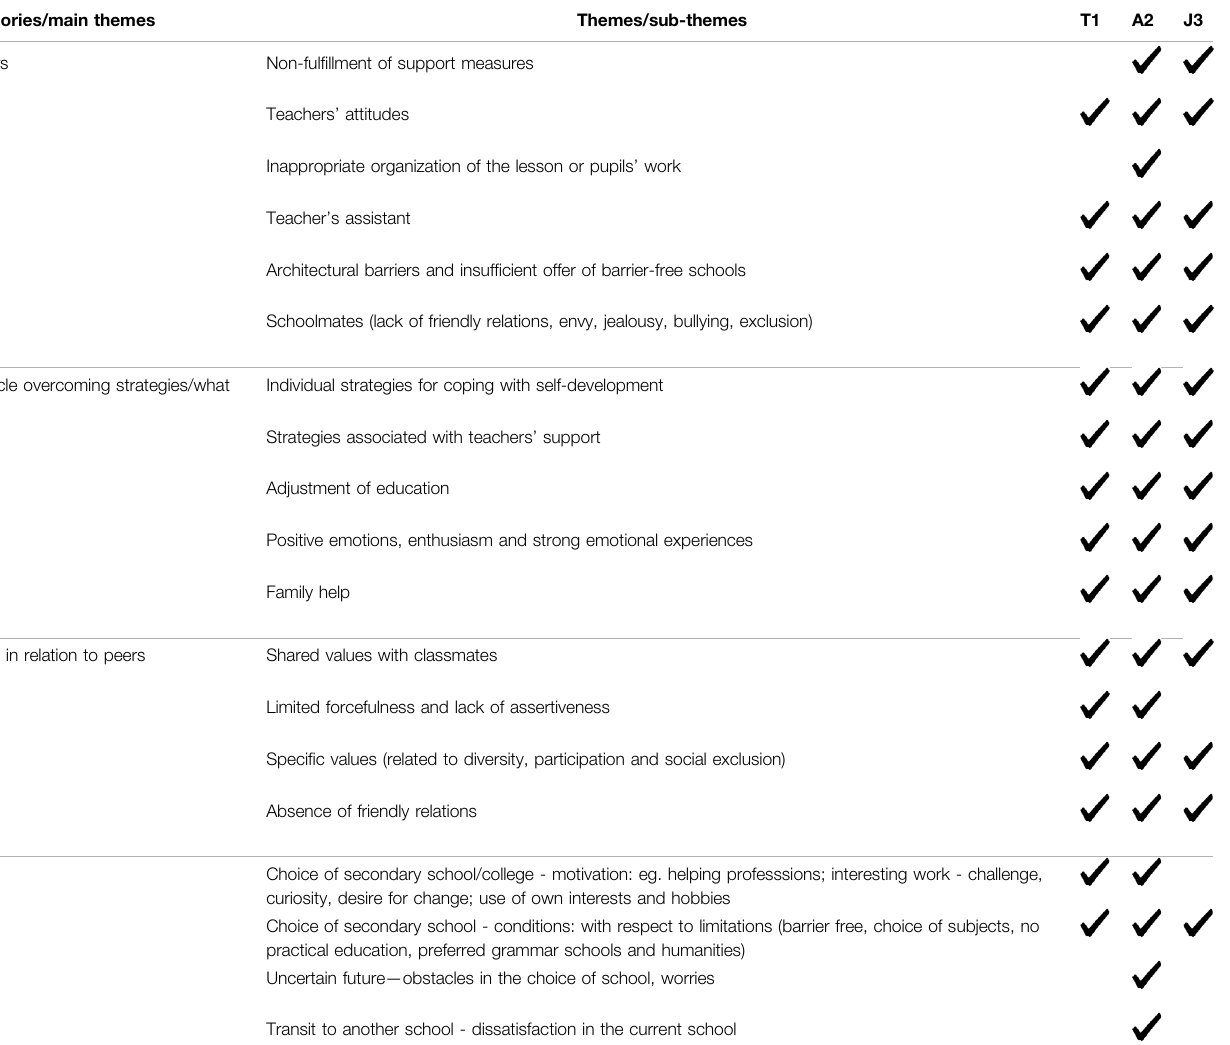
TABLE 1 | The overview of categories, themes and